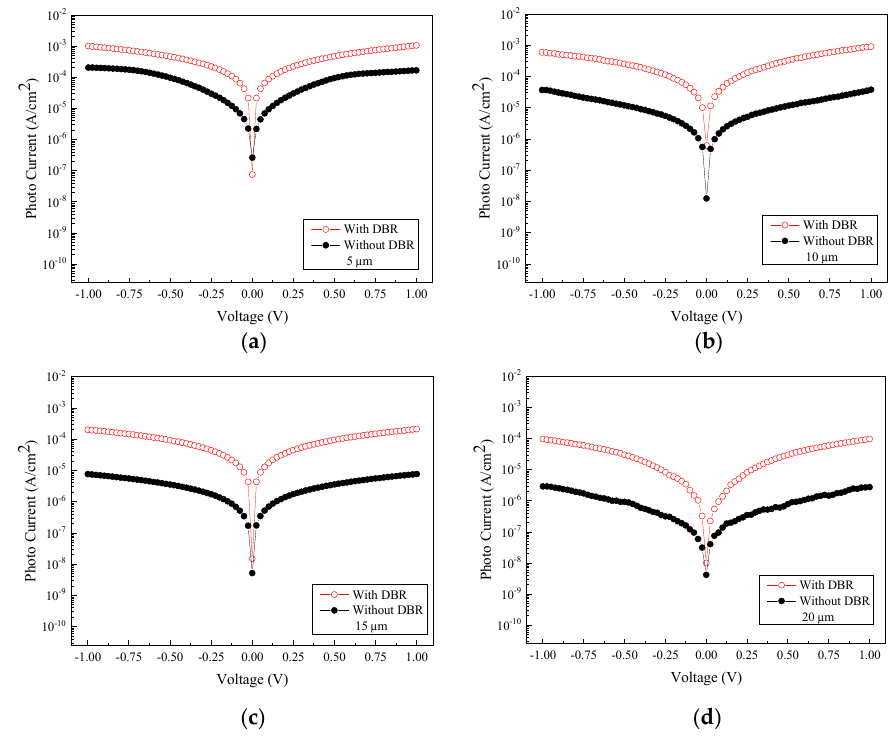
Figure 12. Comparison of photocurrents before and after introducing DBR to the PDs of four differ- ent electrode sizes: ( a ) 5 µm, ( b ) 10 µm, ( c ) 15 µm, and ( d ) 20 µm.